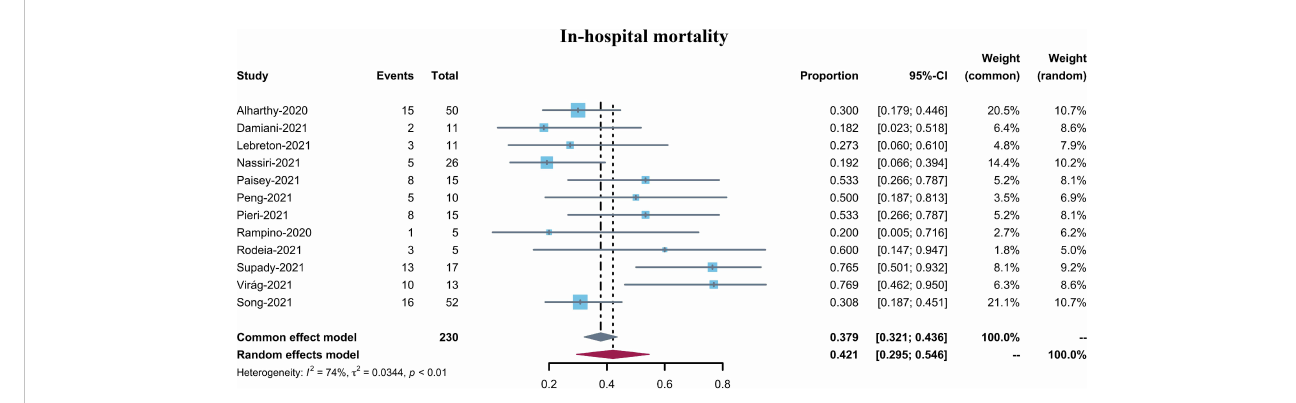
FIGURE 2 Forest plot of in-hospital mortality for COVID-19 patients with CytoSorb treatment. CI: con fi dence